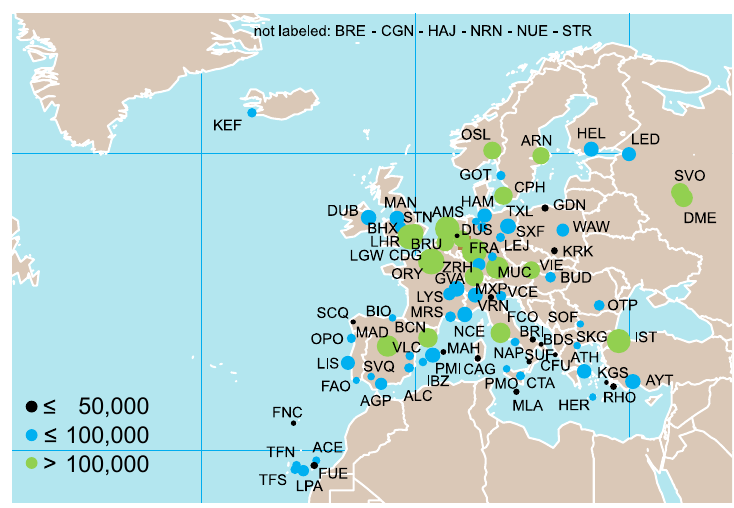
Figure 13. Airport classification according to annual IFR departures in Europe (2013).